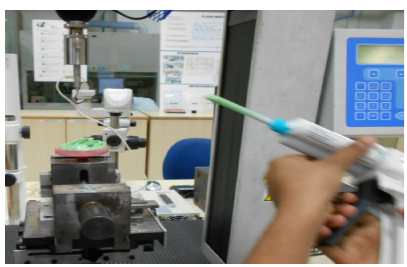
Figure 4. Injec3on of heavy body mate- rial.